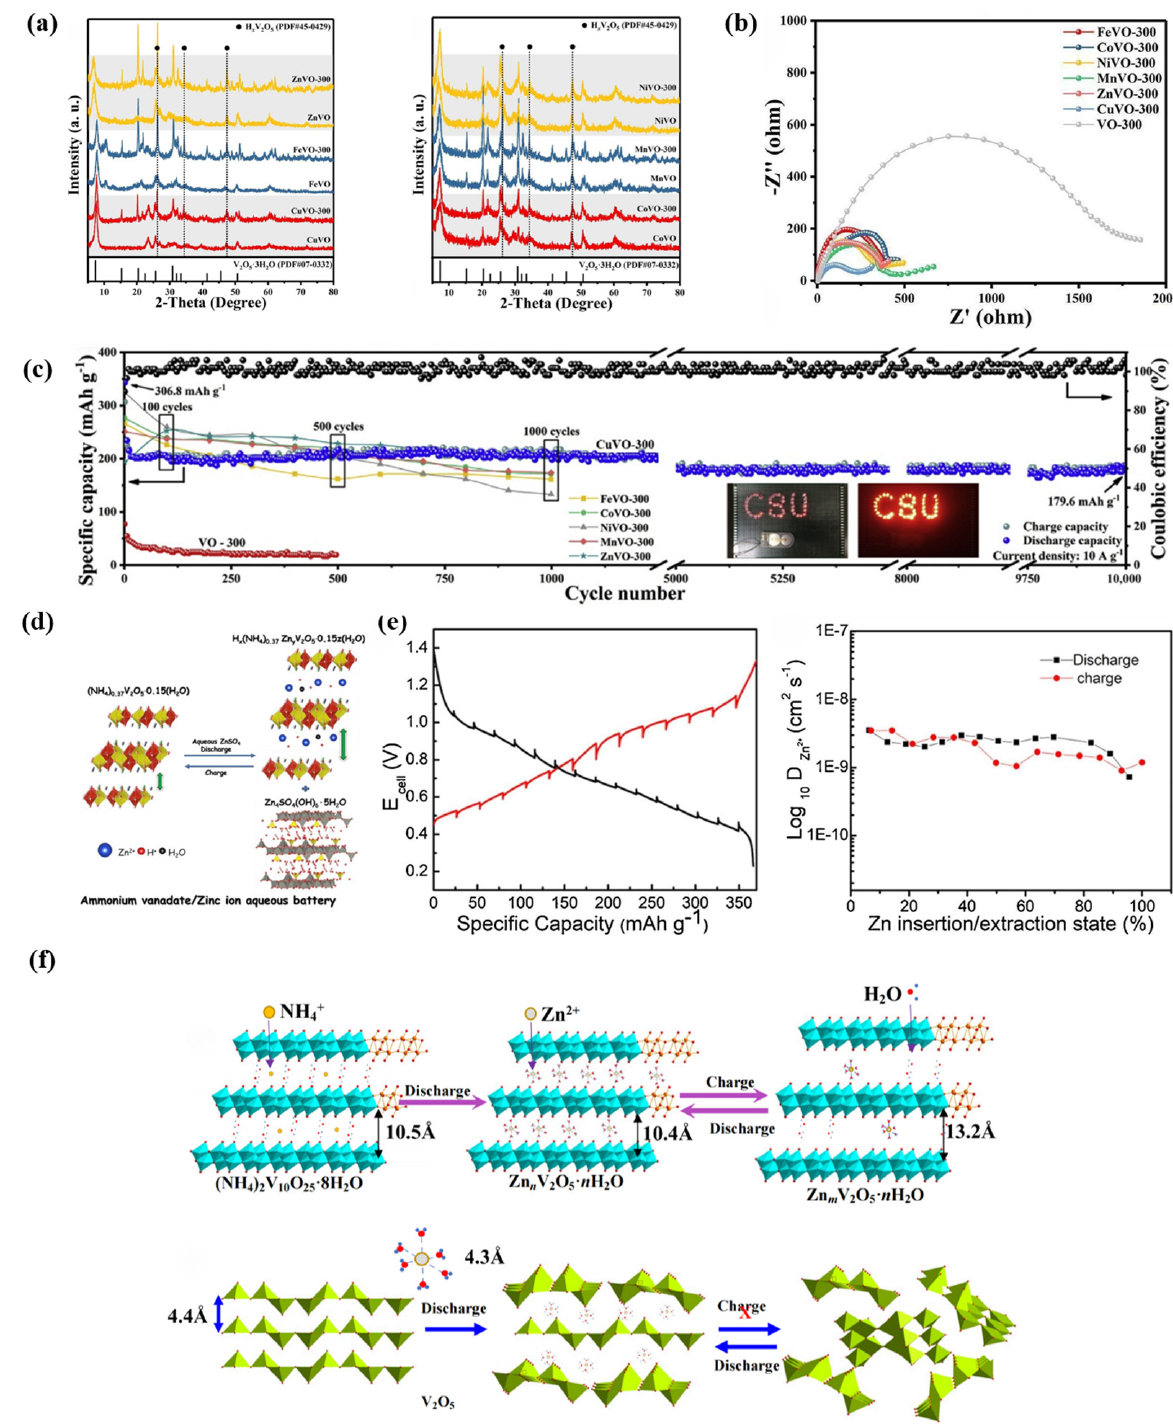
Figure 6. ( a ) X − ray diffraction (XRD) patterns of Cu/Fe/Zn/Co/Mn/NiVO − 0/300 (Ref. [65]). ( b ) Electrochemical Impedance Spectroscopy (EIS) of TVO − 300 and VO − 300 (Ref. [65]). ( c ) Long − term cycling performance of TVO − 300 and VO − 300 (Ref. [65]). ( d ) The structure diagram of (NH 4 ) 0.37 V 2 O 5 ·0.15H 2 O during the charge and discharge processes (Ref. [67]). ( e ) Diffusion coefficients of Zn 2+ calculated from galvanostatic intermittent titration technique (GITT) (Ref. [67]). ( f ) Structural changes of (NH 4 ) 2 V 10 O 25 ·8H 2 O during Zn insertion/extraction (Ref. [68]).